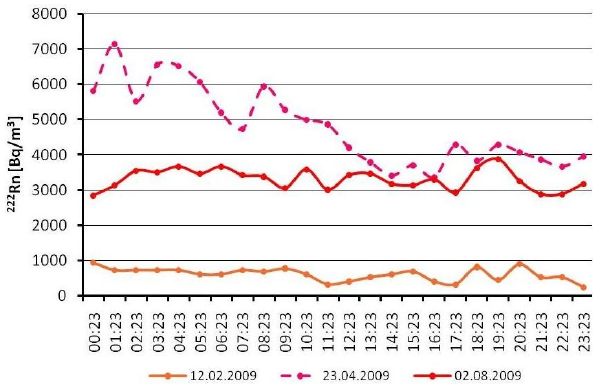
Fig. 5. Fig. 5. Daily pattern of 222 Rn activity concentration changes for three chosen characteristic days, representing three seasons of the year, differing in values and variation in radon concentration in Bear Cave in